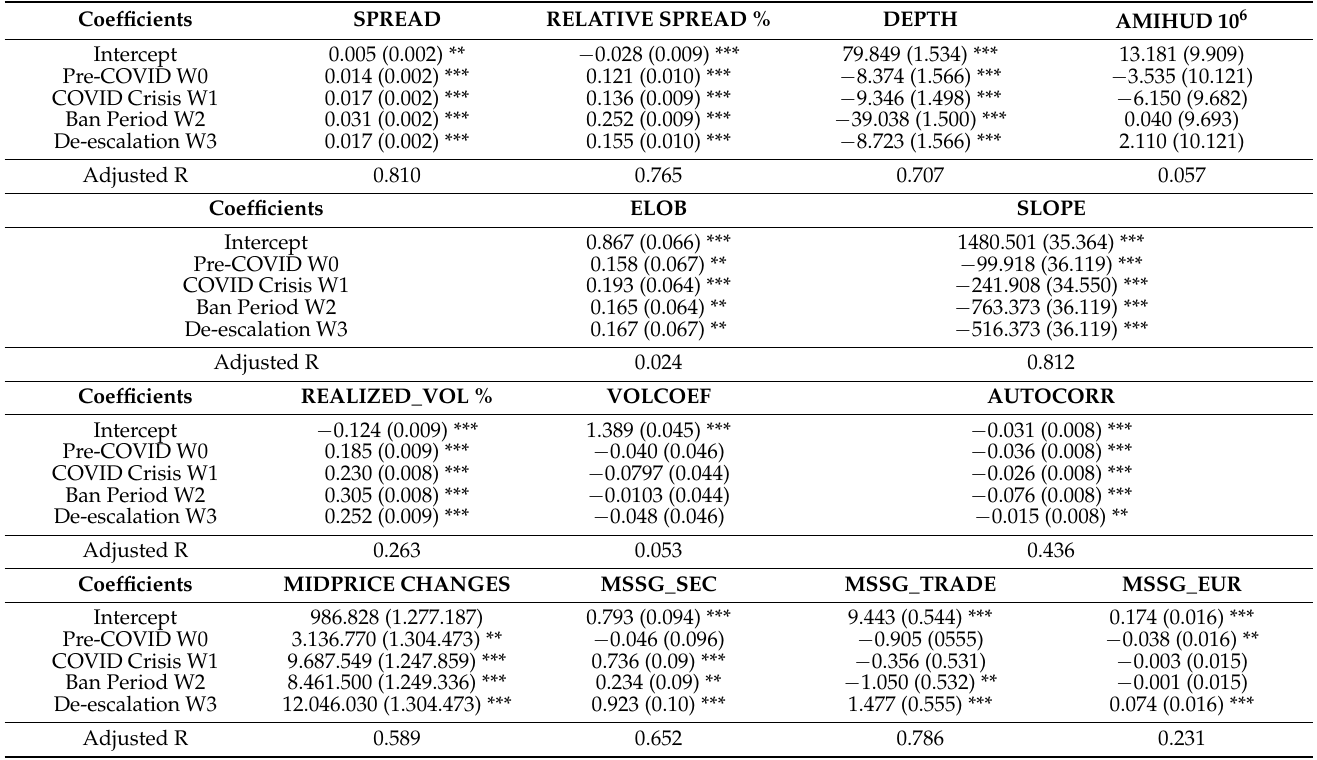
Table 6. Fixed effect panel regression coefficients (standard